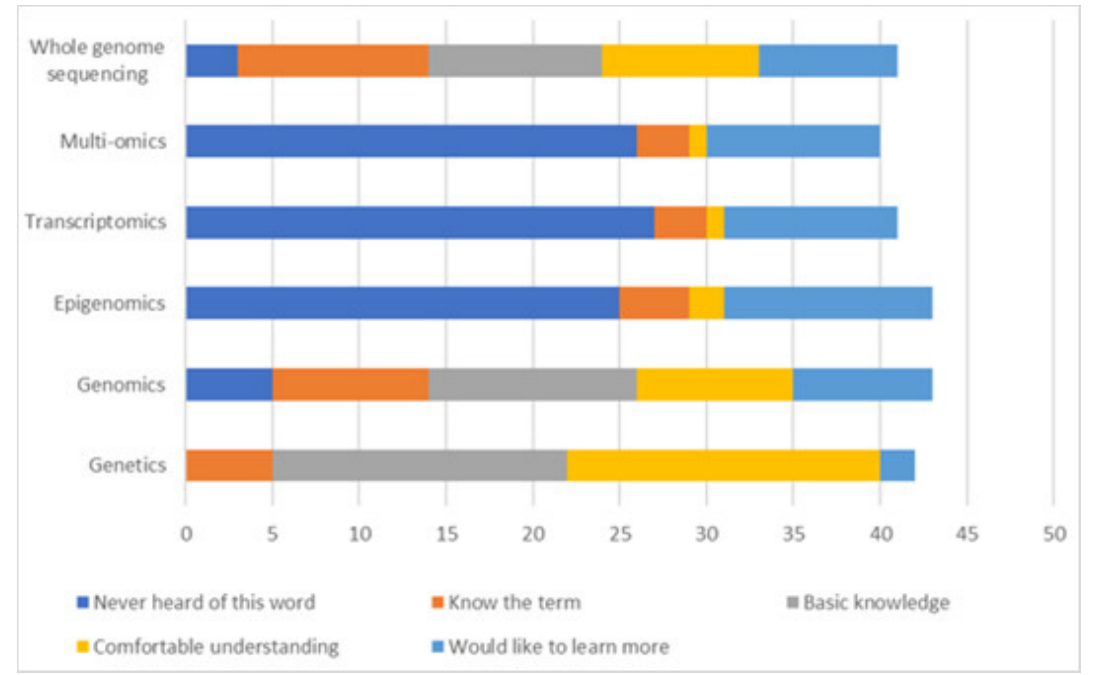
Figure 4. Participant understanding of multiomics terminology.